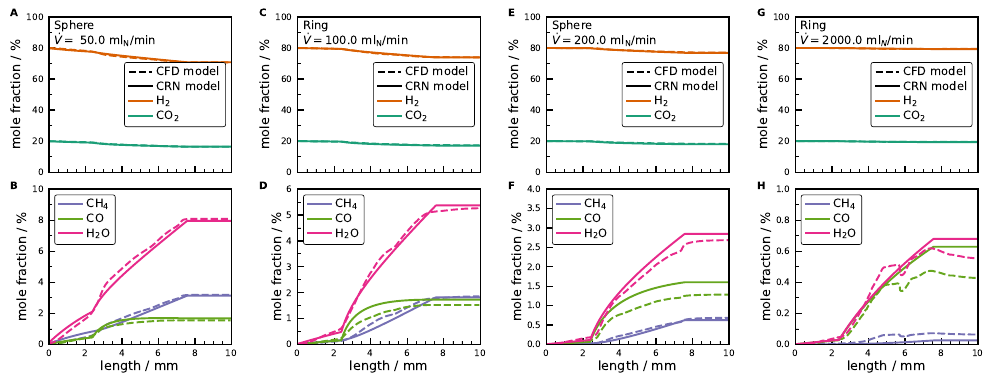
Figure 8. Sphere and ring inside Temkin single chamber. Comparison between 1D CRN model and 3D CFD simulations of axial profiles of ( top ) reactants and ( bottom ) products mole fractions. ( A , B ) ˙ V = 50 ml N min − 1 , ( C , D ) ˙ V = 100 ml N min − 1 , ( E , F ) ˙ V = 200 ml N min − 1 , and ( G , H ) − 1 . ˙ V = 2000 ml N min